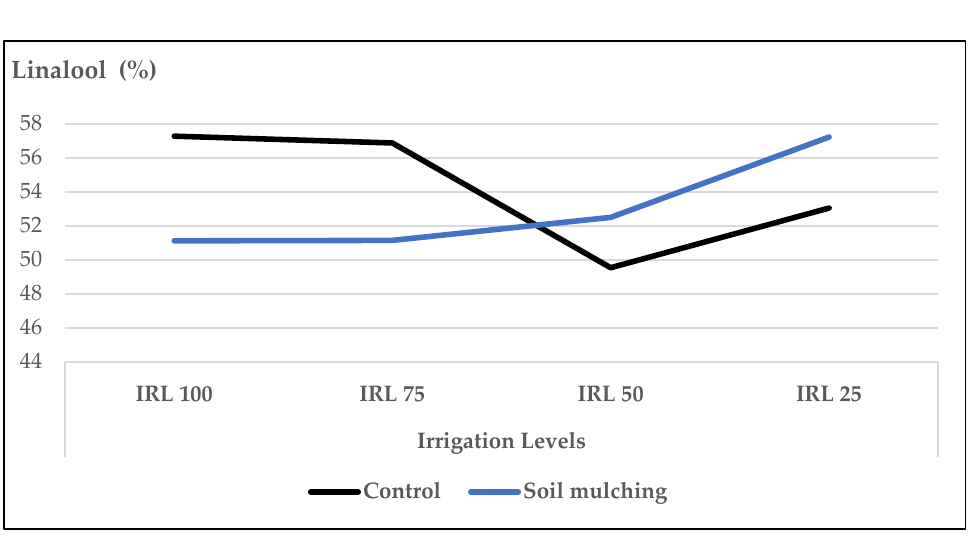
Figure 9. Mean values of linalool (%) at di ff erent IRLs of O. basilicum L. essential oil under soil mulching and control conditions; IRL 100 = 100% FC; IRL 75 = 75% FC; IRL 50 = 50% FC; IRL 25 = 25 °C.